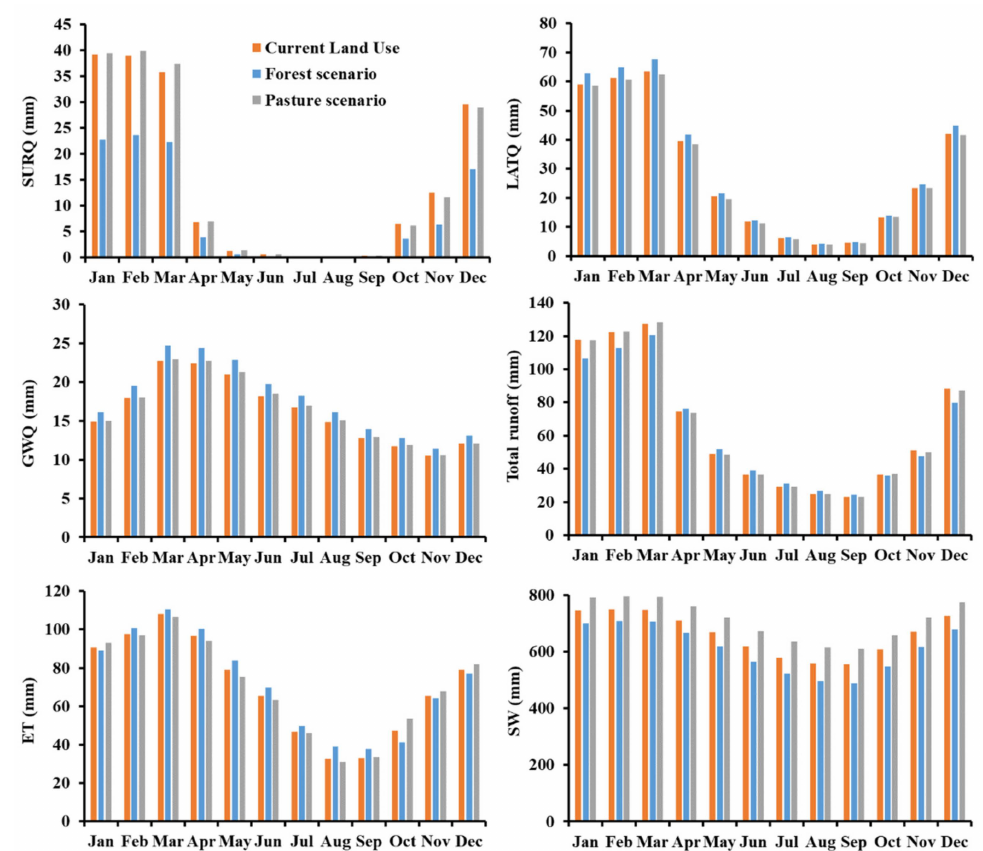
Figure 7. Monthly surface runoff (SURQ), lateral runoff (LATQ), groundwater (GWQ), water yield, actual evapotranspiration (ET), and soil water (SW) using calibrated SWAT model in current land use and the forest and pasture scenarios. The data are between 1982 and 2013 of the Uberaba River